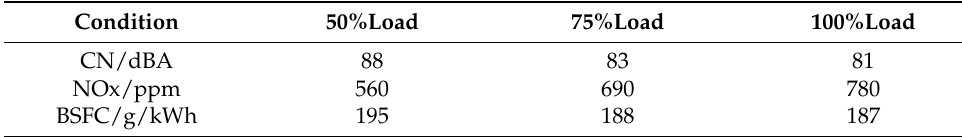
Table 3. Summary of the ideal values in objective function.